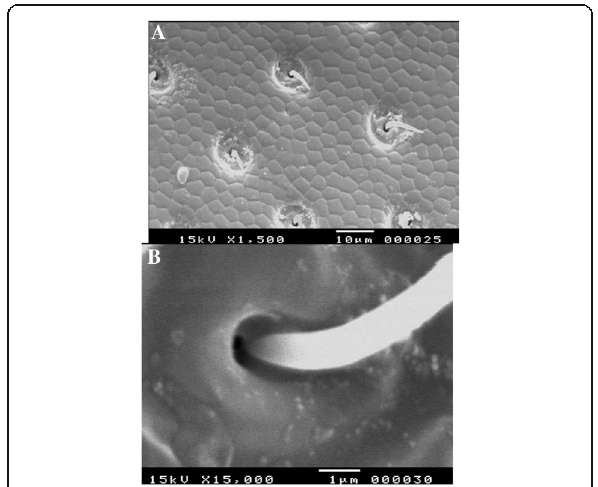
Fig. 12 a SEM of the elytra showing the pits. b Higher magnification of the elytra of T. confusum showing the seta with large pore posteriorly close to the base of the seta